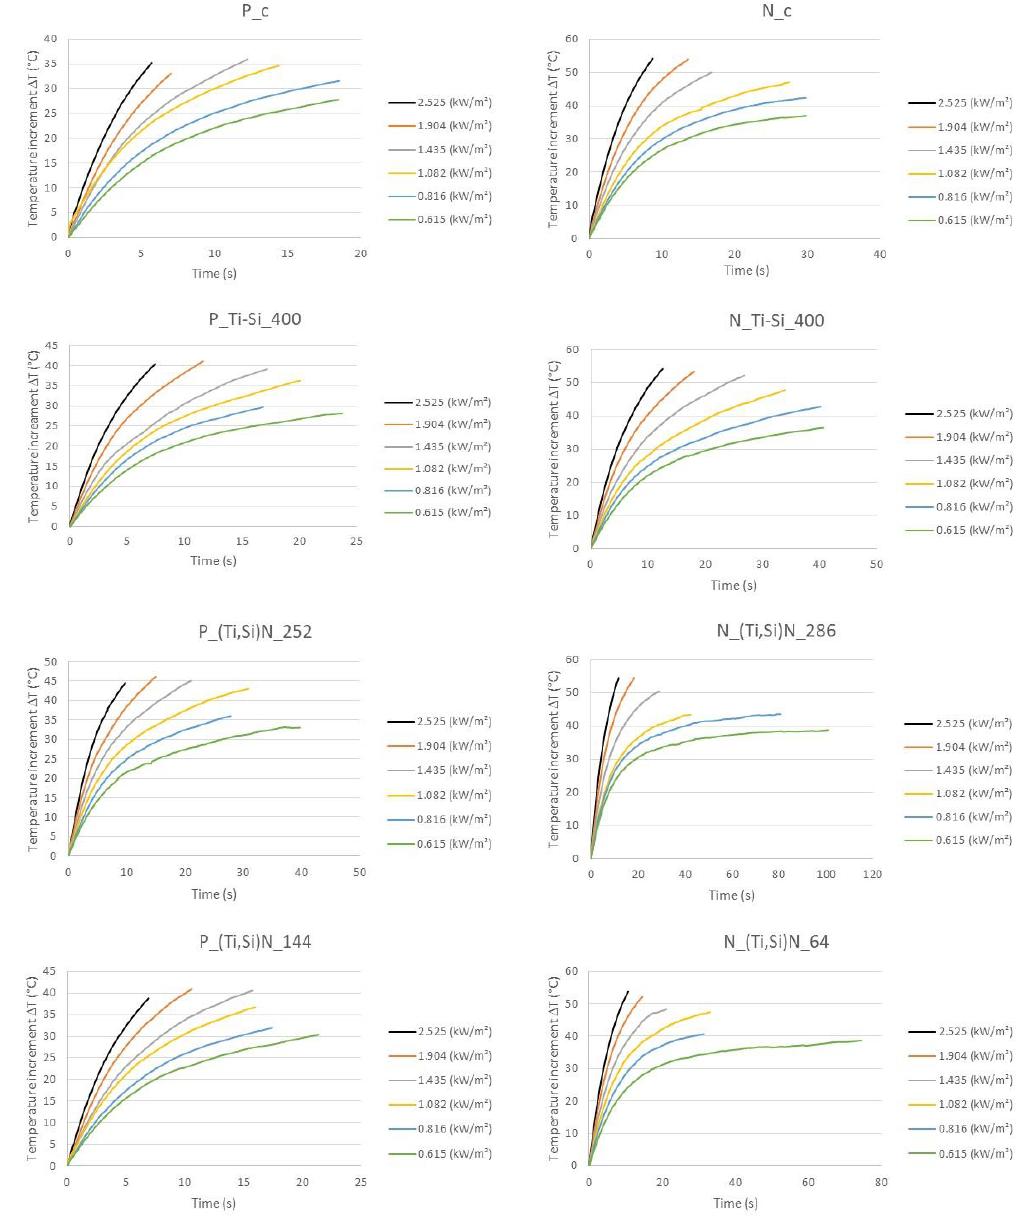
Figure 16. Results of heat radiation tests (samples named in accordance to Table 2).